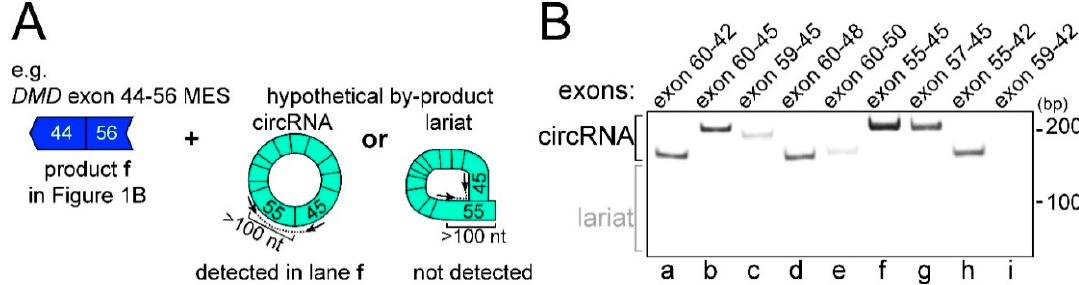
Figure 2. Expression analysis of circular RNA (circRNA) products. ( A ) A schematic of multiple exon skipping (MES) product and its hypothetical by-products. A case of the exon 44–56-connected DMD MES is shown as an example. Although circRNA is generally a candidate of the hypothetical by-product, exonic lariat is another candidate by the re-splicing model [27]. Divergent reverse-transcription polymerase chain reaction (RT-PCR) can amplify circRNA and exonic lariat; ( B ) RT-PCR results for hypothetical by-products of MESs. Exons involved in back-splicing or re-splicing are indicated at the top. Molecular markers are indicated on the right. No lariat exon-type products were detected.